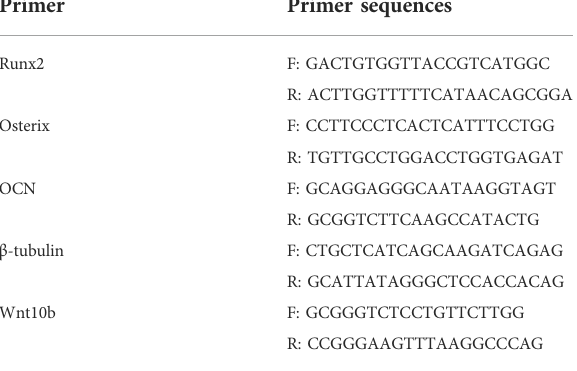
TABLE 1 Primer sequences used in this study.